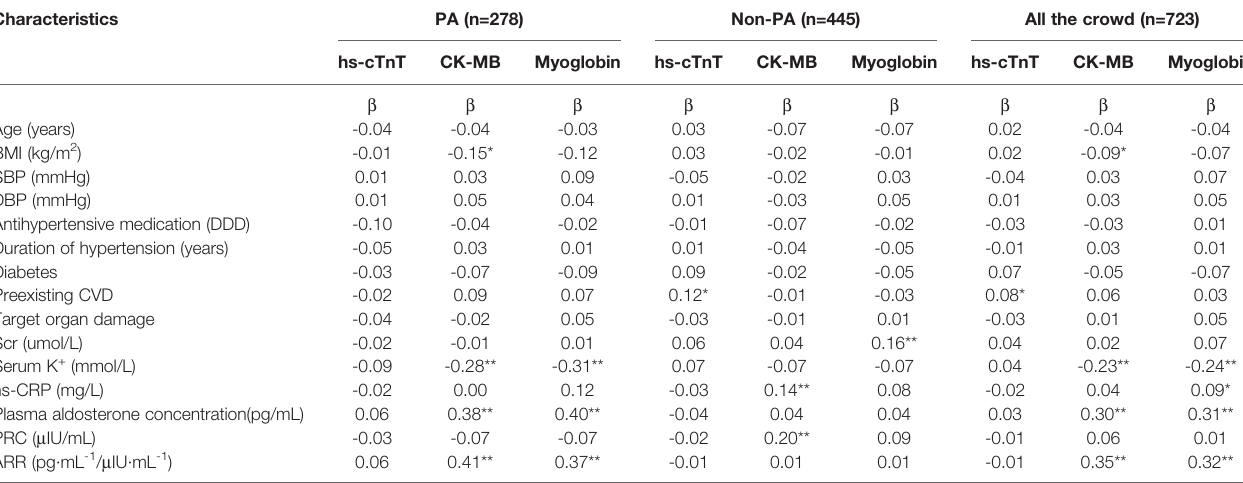
TABLE 2 | Univariate linear regression between myocardial injury markers and clinical characteristics in the study participants.